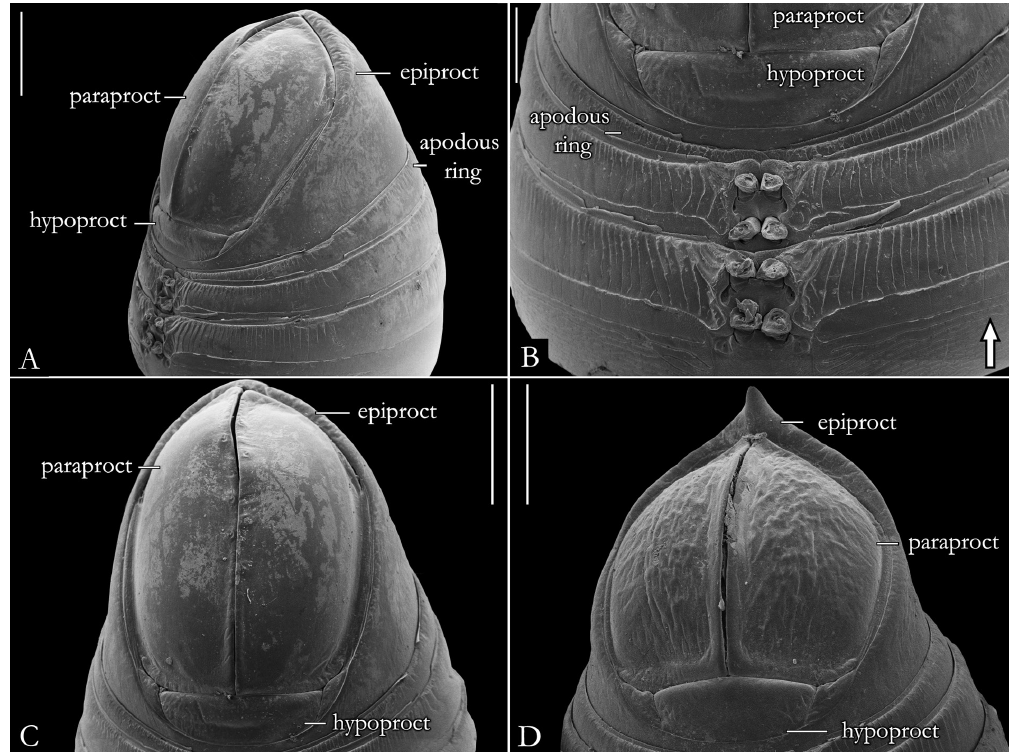
Fig. 28. SEM images of posterior rings. A–C . Pseudonannolene robsoni Iniesta & Ferreira, 2014 (IBSP 3506). D . P. buhrnheimi Schubart, 1960 (IBSP 2397). Scale bars: A, C–D = 1 mm; B = 0.5